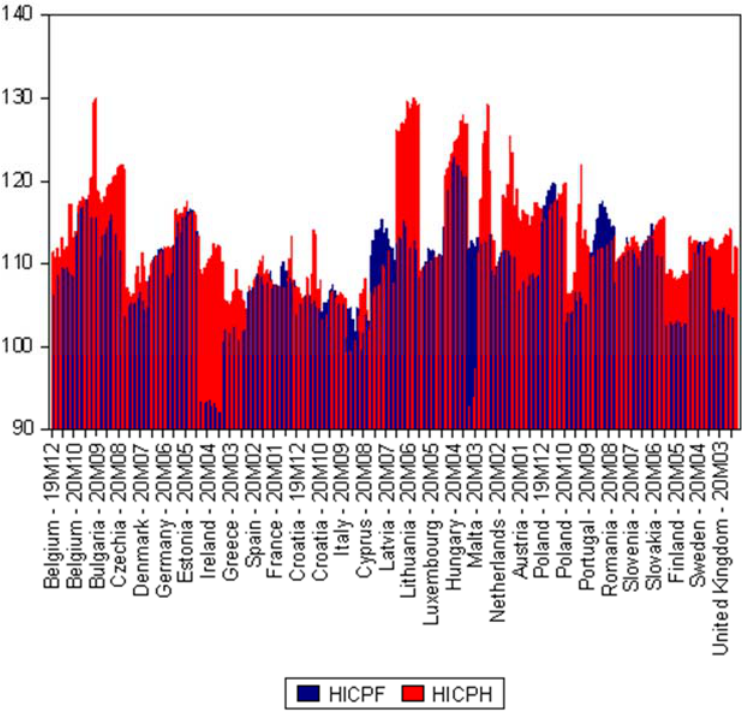
Figure 4. Evolution of harmonized indices of consumer prices ( HICPF , HICPH ) across the country sample. Note : Figures displayed after the symbol M indicate the number of the month in the calendar year. Figure 4 indicates that the highest levels of inflation were reached by economies from Lithuania, Hungary, Malta, the Netherlands, and Bulgaria.